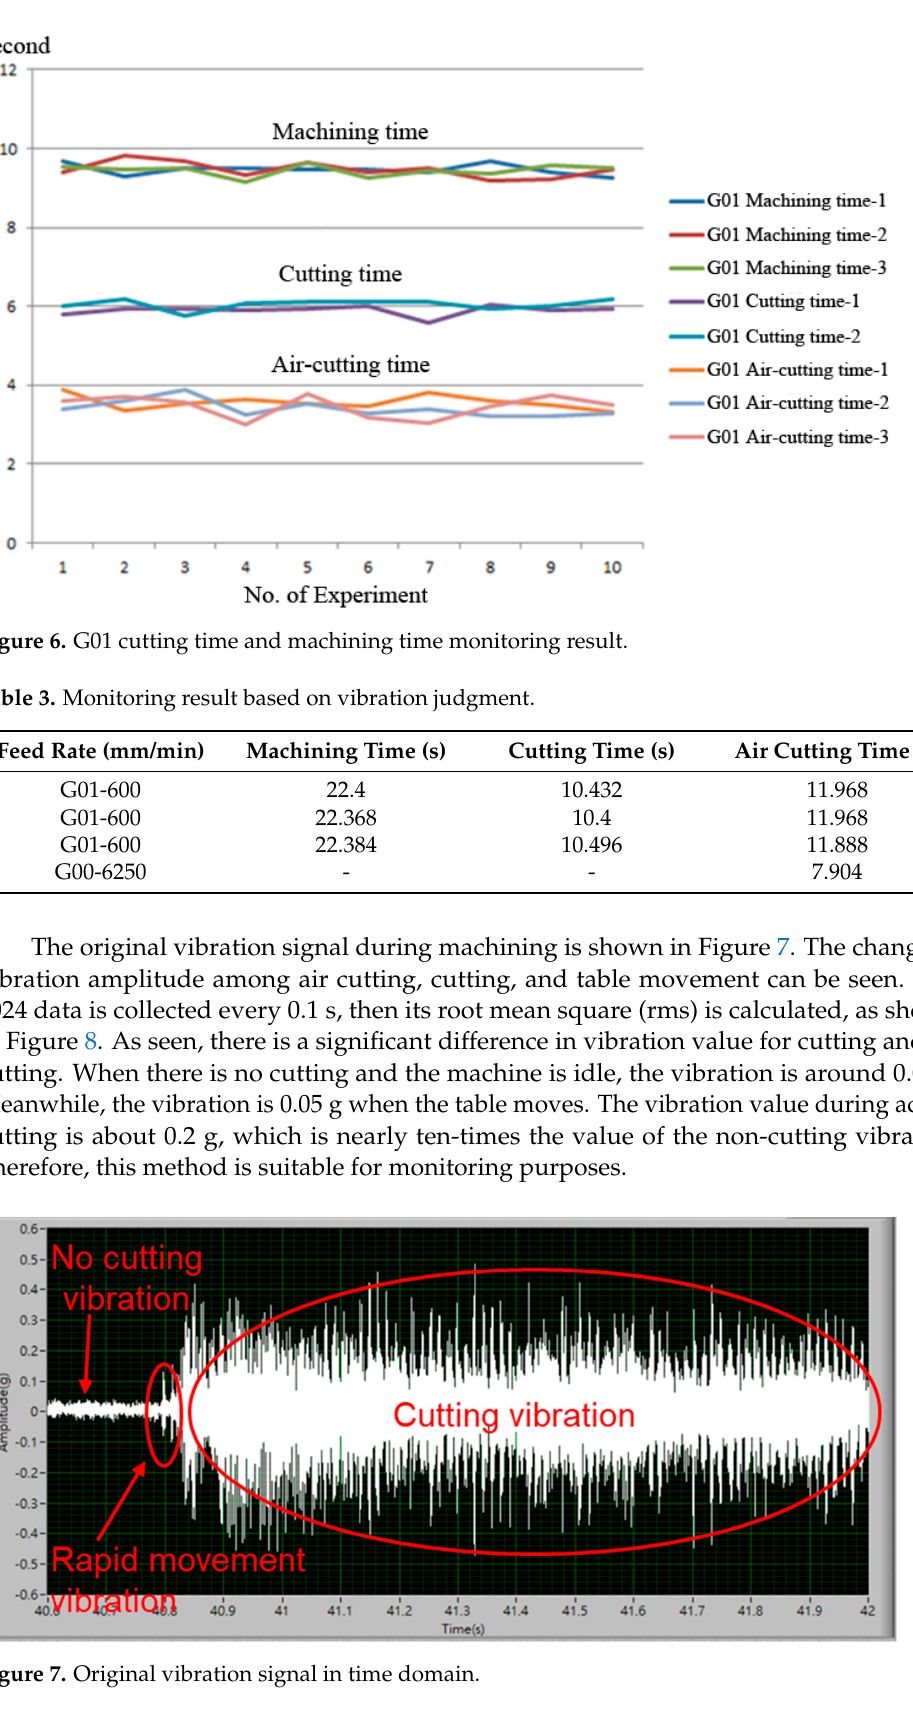
Figure 8 . RMS vibration value.